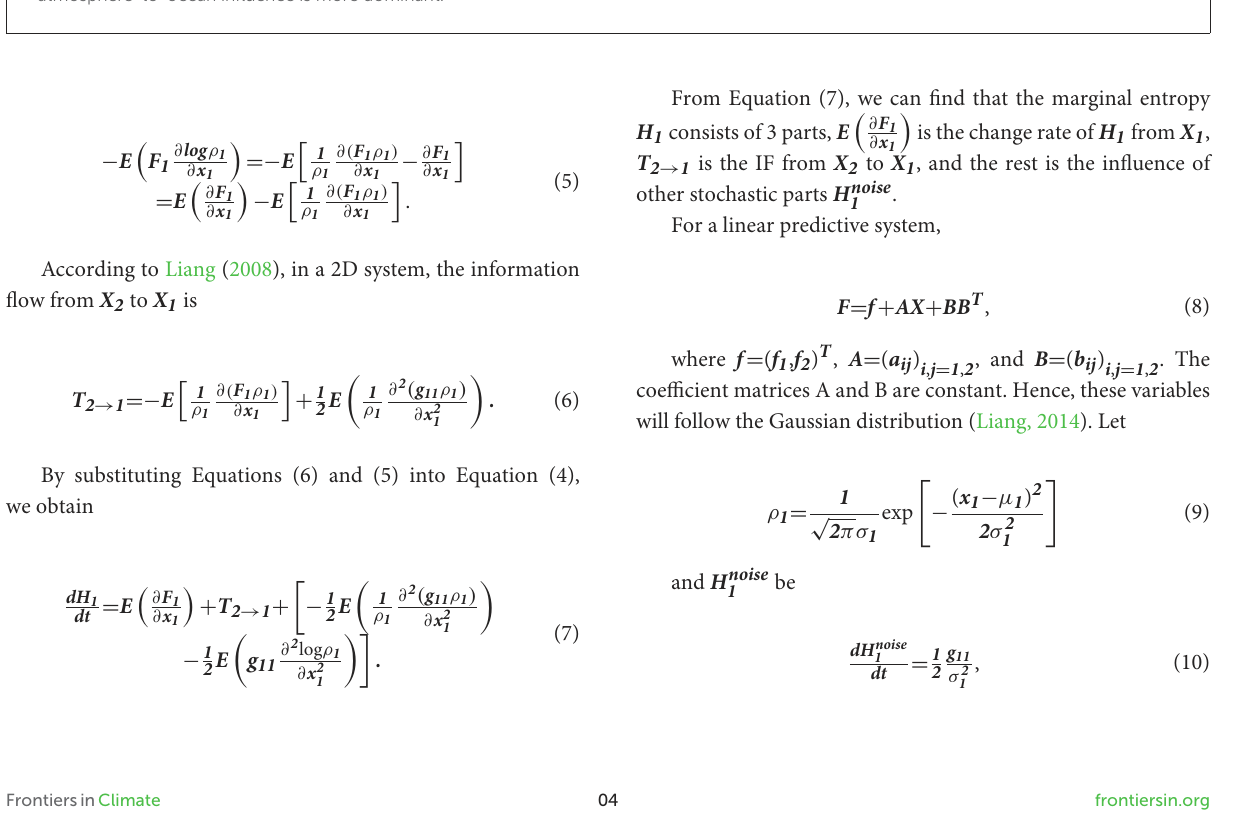
FIGURE3 Magnitude of C local . Positive values indicate that the ocean-to-atmosphere influence is more dominant, while negative values signify that the atmosphere-to-ocean influence is more